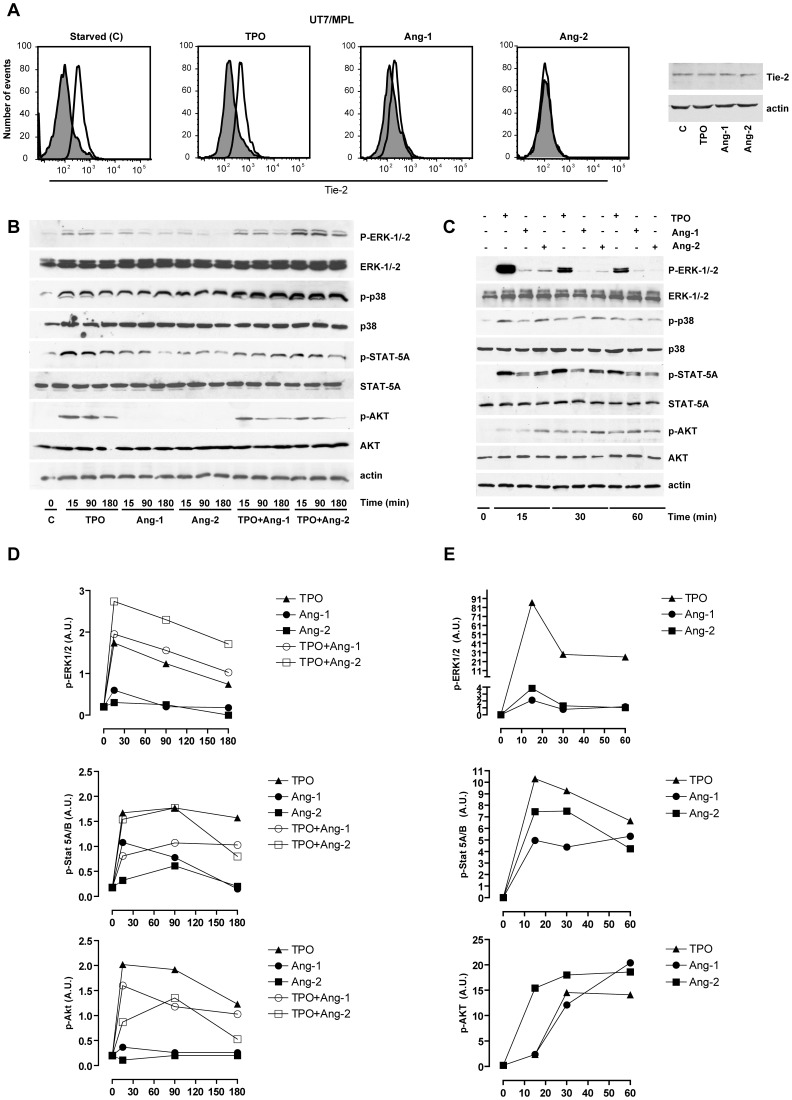
Angiopoietin and TPO-induced cell signaling in UT7/mpl cells and in normal megakaryocytes.
A – Flow cytometry and Western Blot analysis of Tie-2 expression in UT7/mpl cells starved for 16 h of growth factors and then stimulated for 15 min either in the absence (C ) or in the presence of either TPO or Ang-1 or Ang-2. B – UT7/mpl cells have been starved for 16 h of growth factors and then stimulated for various times (15, 90 and 180 min) with either TPO or Ang-1 or Ang-2 or TPO+Ang-1 or TPO+Ang-2. The cells were then harvested, lysed and analyzed by western blotting for the expression of p-ERK-1/−2, p-38, p-STAT-5A and p-AKT and their non-phosphorylated forms. Beta-actin was used to normalize for sample loading. A representative experiment out of three performed is shown. C – Day 7 megakaryocytes derived from unilineage cell cultures of normal CB CD34+ cells have been first starved for 6 h of exogenous growth factors and then stimulated for various times (15, 30 or 60 min) with either TPO or Ang-1 or Ang-2. Cells were then washed, lysed and processed as above. Beta-actin was used to normalize for sample loading. D-E Densitometric analysis of WB autoradiograms, performed on UT7/mpl (panel D) or d7 PB MKs (panel E) expressed as absorbance arbitrary units. The results represent the mean values observed in three separate experiments.